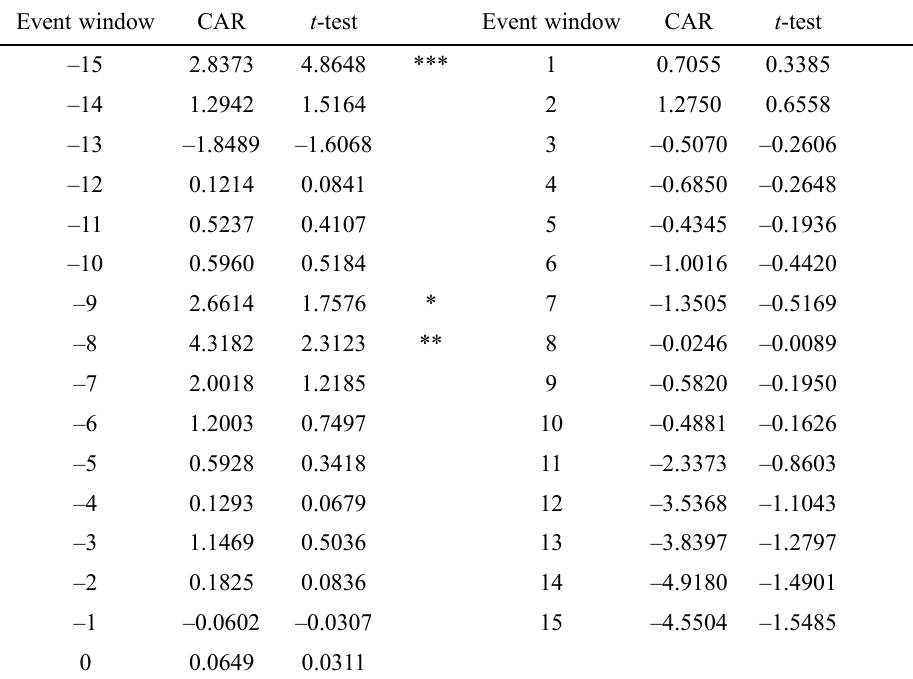
Table 8. CAR of other medical–related during the period of infectious diseases Event window